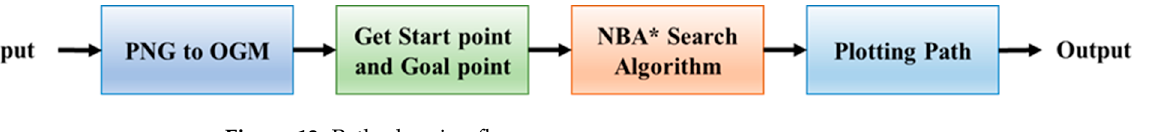
Figure 13. Path planning